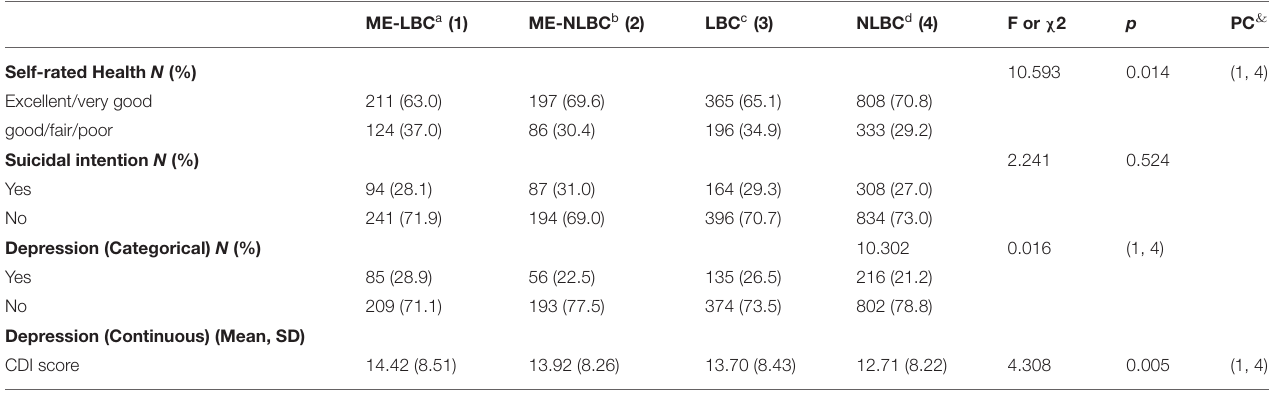
TABLE 3 | Health outcomes of children stratified by groups.